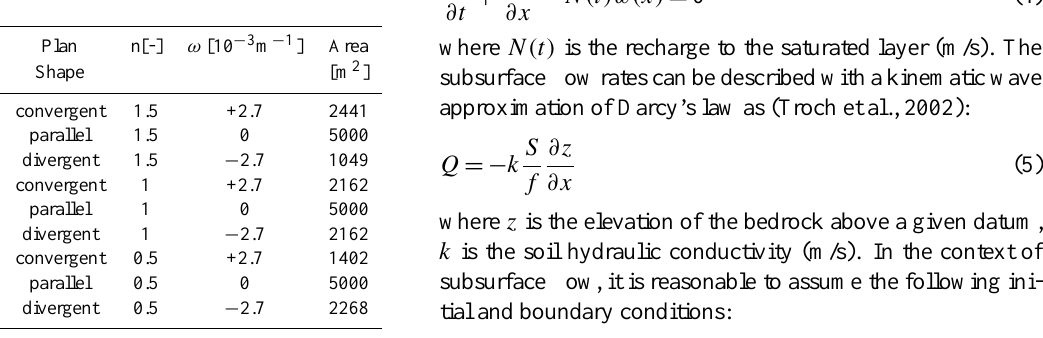
Table 1. Geometrical parameters for the nine characterized hill- slopes (after Talebi et al., 2008a).